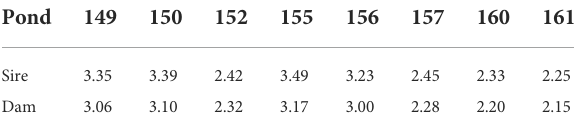
TABLE 2 Morisita-Horn overlap (similarity) index of prawn family distribution across ponds (a) sire (below diagonal) and (b) dam (above